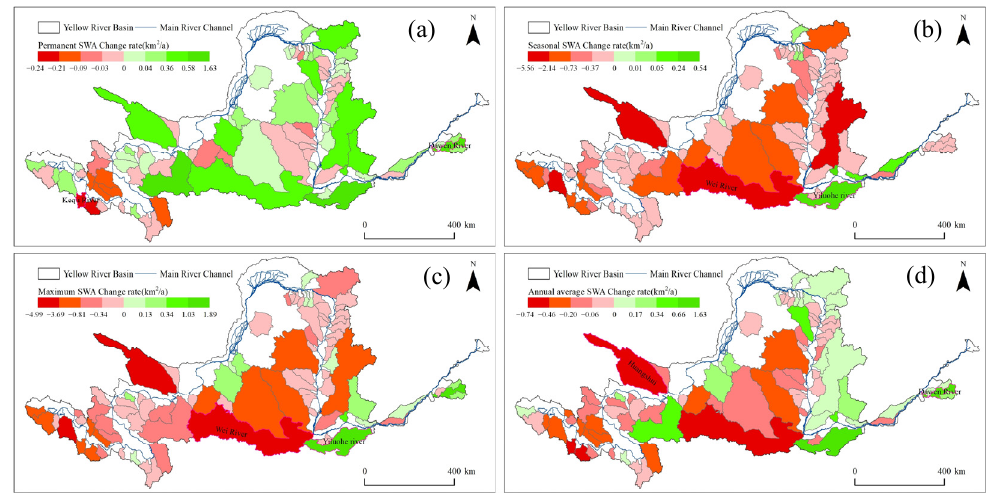
Figure 11. Changes in the different types of water bodies in each sub-basin in the YRB during 1986–2019. Panels ( a – d ) are for the permanent, seasonal, maximum, and annual average SWAs, respectively.